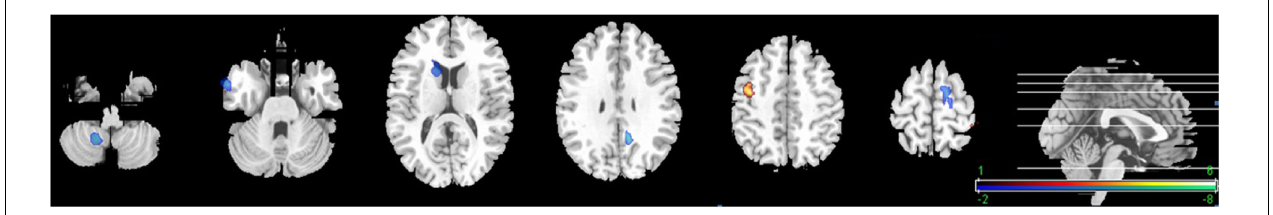
FIGURE 3 | Significant correlations between ReHo and training profiles in PCCPs ( P < 0.05, AlphaSim corrected, a combined threshold of P < 0.001, and a minimum cluster size of 20 voxels). Hot and cold colors indicate positive and negative correlations, respectively. The numbers on the right color-bar refer to the t- value. The left and right sides in this figure correspond to the right and left sides of the brain, respectively. Further details of these regions are presented in Table 2 .